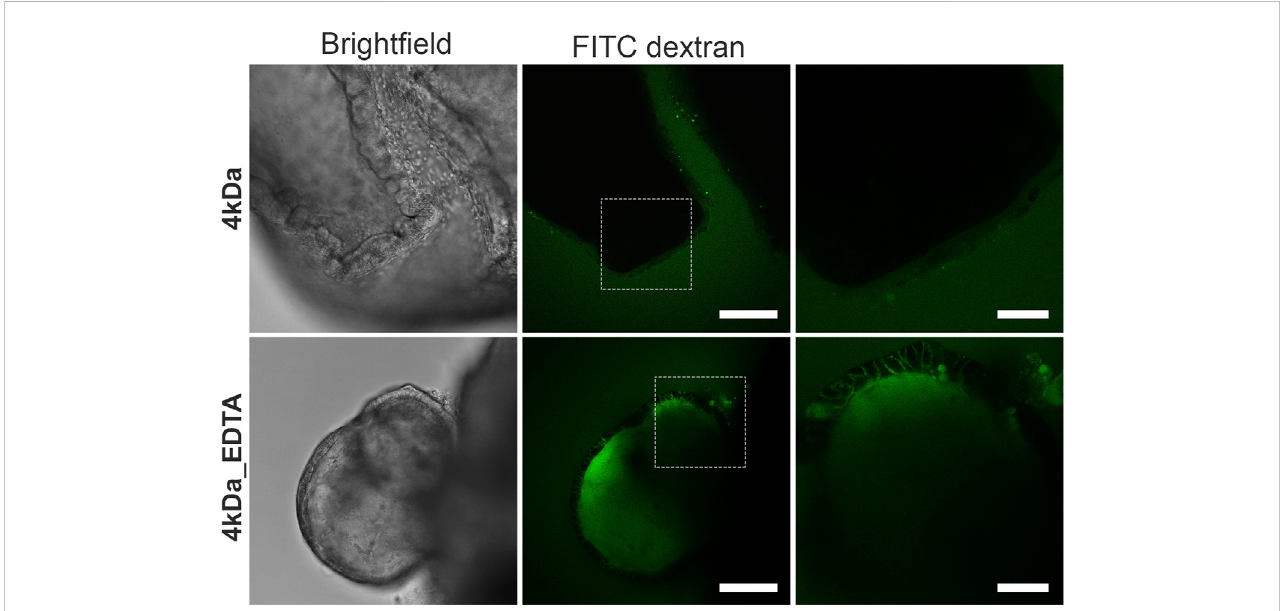
FIGURE 2 Suspension intestinal organoids show epithelial barrier integrity by a FITC-dextran diffusion assay. Suspension organoids exclude the 4 kDa FITC- dextran, showing tight epithelial barrier formation (top row). When organoids are treated with 2 mM EDTA (bottom row), the barrier is disrupted and FITC- dextrandiffusesintotheintracellularspaceandtheorganoidlumen.Whiteboxesinthemiddleimagesdelineatetheareasshowninthezoomedimagestothe respective right. Scale bars: 100 μ m (left and middle) and 50 μ m (right).